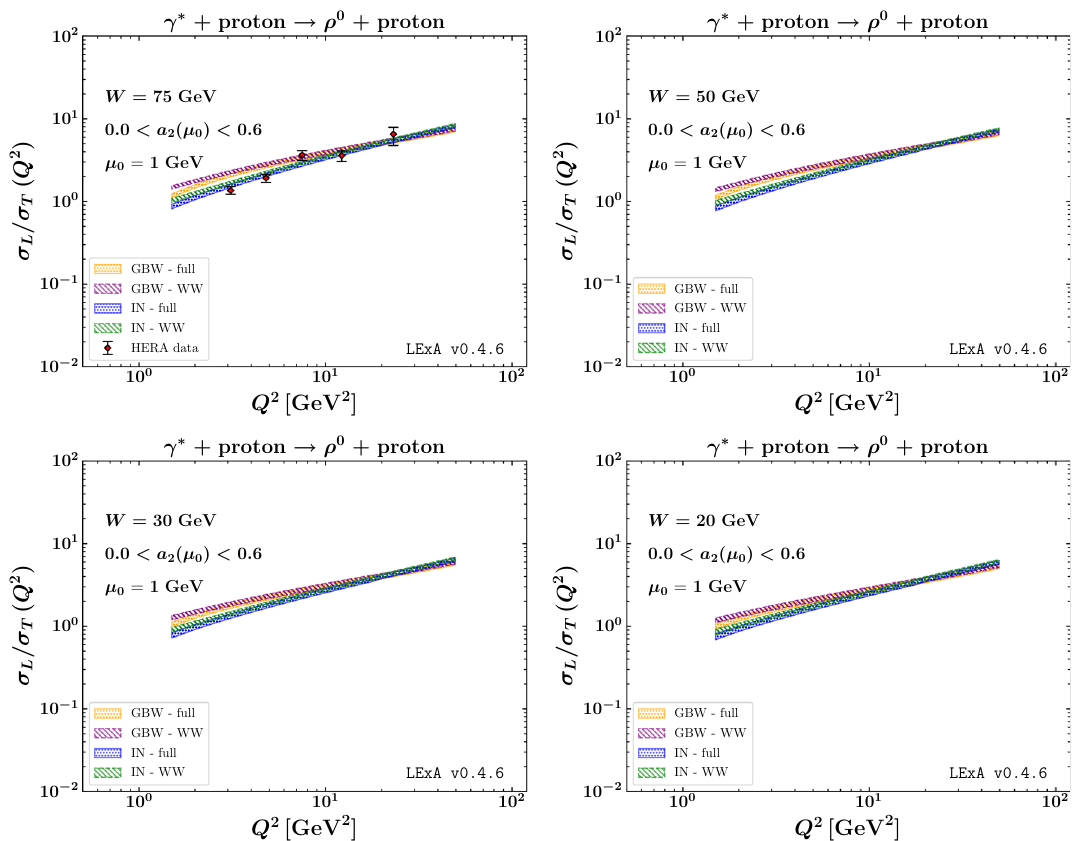
Fig. 8 Q 2 -dependence of the polarized cross-section ratio, σ L /σ T , for the GBW and IN UGD models, at W = 75 GeV HERA (left upper panel) and at W = 20 , 30 , 50 GeV relevant for EIC (the remaining pan-